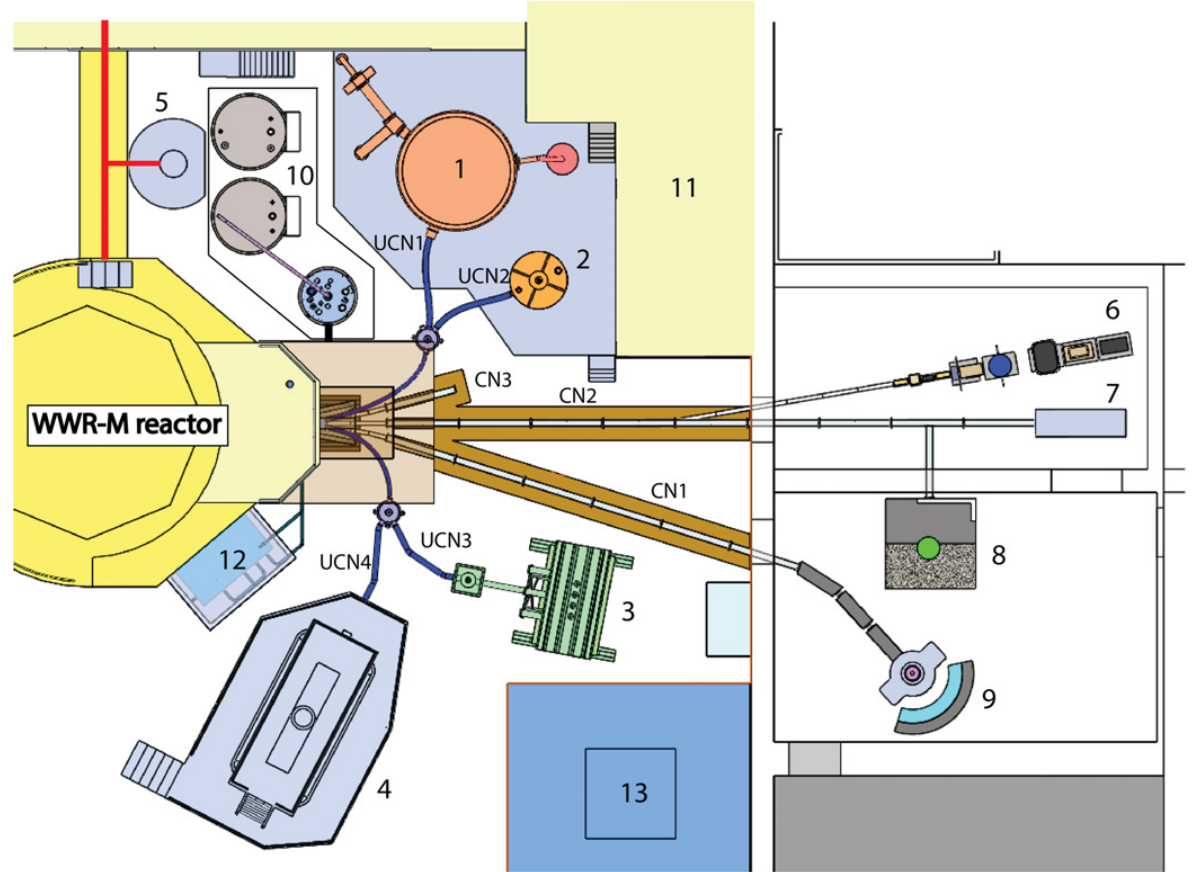
Figure 3. Schematic implementation of experimental equipment in the main hall of the WWR-M reactor hall. Beams of ultracold neutrons are named UCNx, cold and very cold neutron beams are named CNx. 1 – EDM spectrometer, 2 – UCN magnetic trap, 3 – n-n’ experiment, 4 – UCN gravitational trap, 5 – Diffractometer, 6 – Reflectometer, 7 – Polarimeter, 8 – Powder diffractometer,